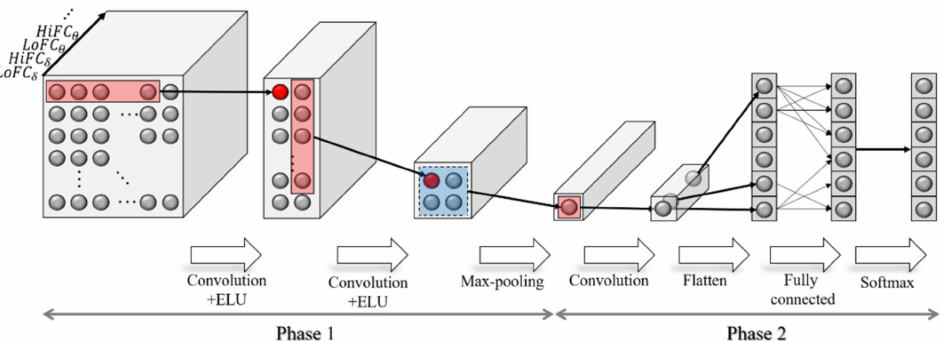
Figure 3. Structure of the CNN for the classification of a three-dimensional input consisting of low- and high-order FCs at five frequency bands. The cuboids represent the input and output variables of each process. Circles inside the rectangles represent data points. The first input variable consists of 10 layers of feature maps. Rectangles with solid and dashed lines inside the cuboids represent the convolutional and pooling filters,